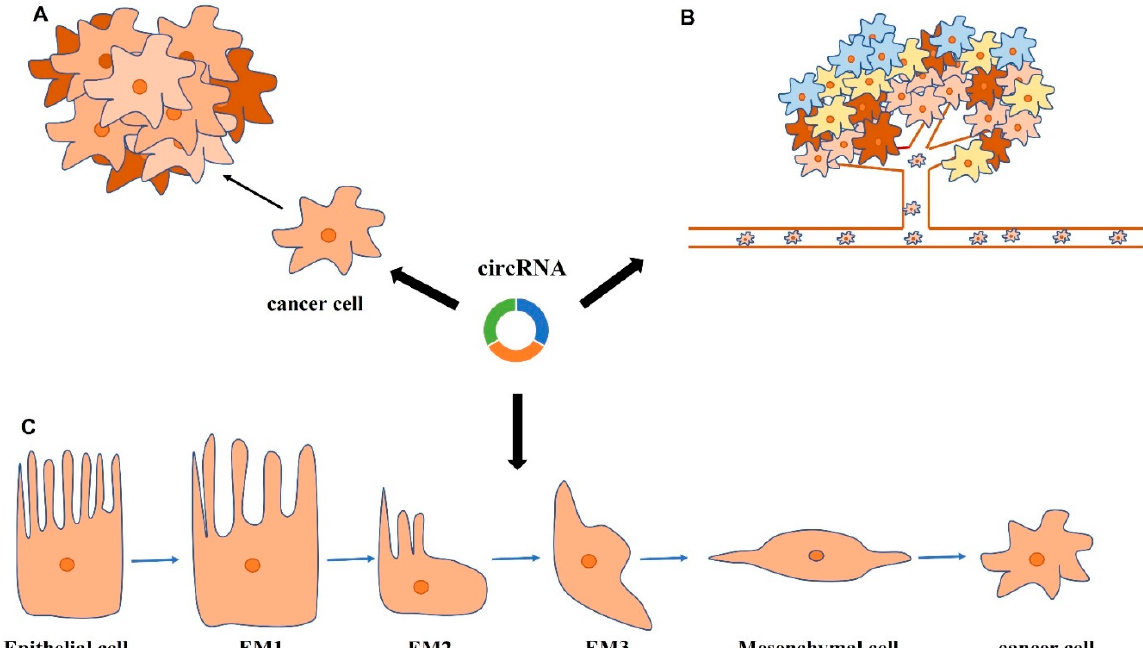
Figure 2. CircRNAs regulate cell proliferation, migration and invasion, and modulate epithelial-mesenchymal transition (EMT). ( A ). Roles of circRNAs in cell proliferation. ( B ). Roles of circRNAs in cell migration and invasion. ( C ). Roles of circRNAs in modulating EMT. Table 1. CircRNAs and their mechanisms in bladder cancer progression.